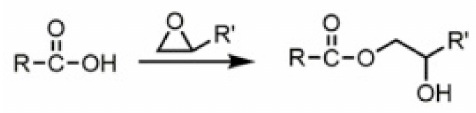
Figure 12. Ring opening reaction.